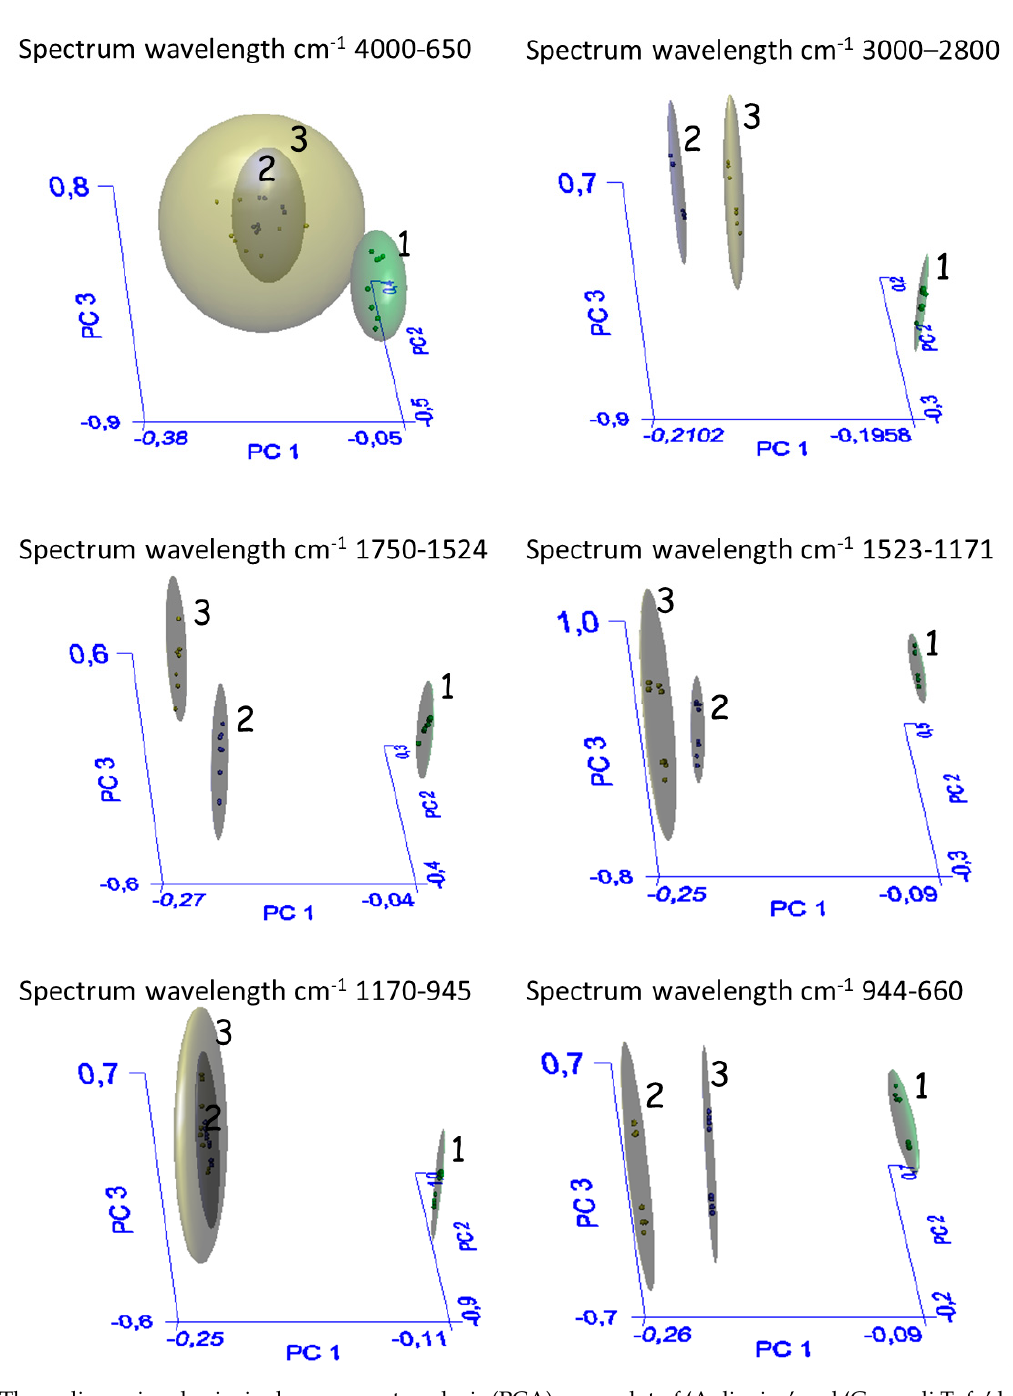
Figure 2. Three-dimensional principal component analysis (PCA) score plot of ‘Aglianico’ and ‘Greco di Tufo’ leaf extract with EtOH, MetOH:H 2 O (70:30), H 2 O, derived from SIMCA. Data analysis was performed in smaller ranges of spectrum reported above each plot. The spectrum ranges correspond to those reported in Table 3. 1 = EtOH extract; 2 = MetOH:H 2 O (70:30) extract; 3 = H 2 O